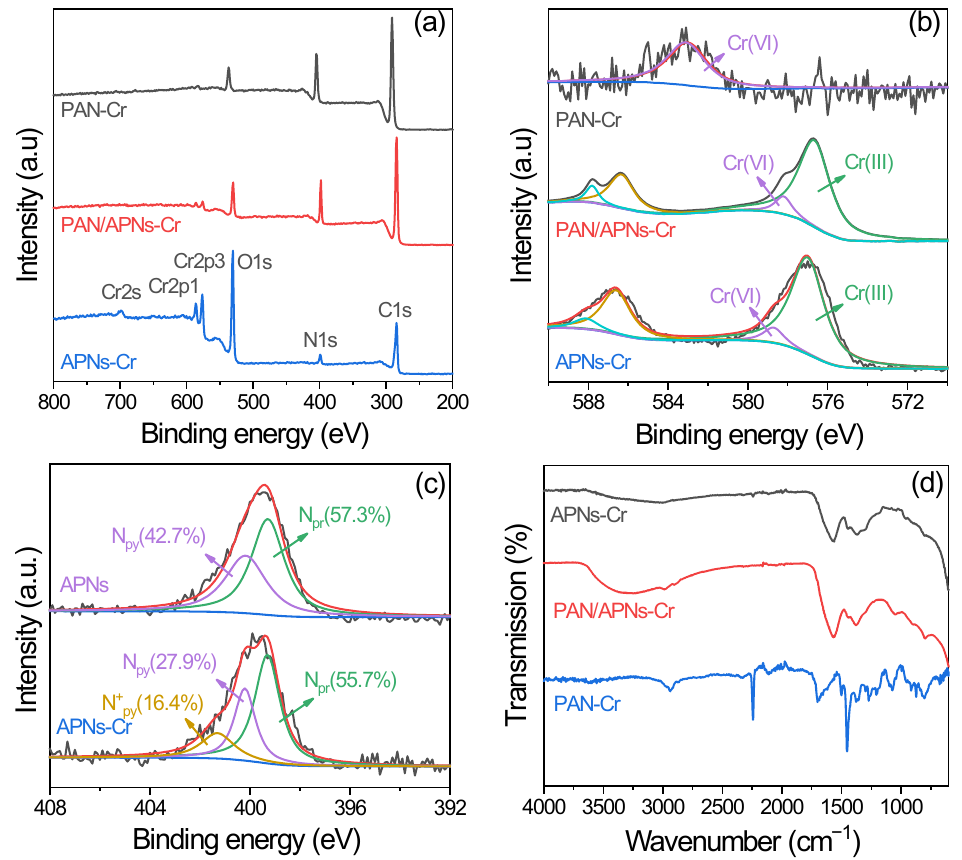
Figure 9. XPS survey scan spectra ( a ), high-resolution spectra of Cr 2p ( b ) and N1s ( c ) and FTIR spectra ( d ) of adsorbents after adsorption.